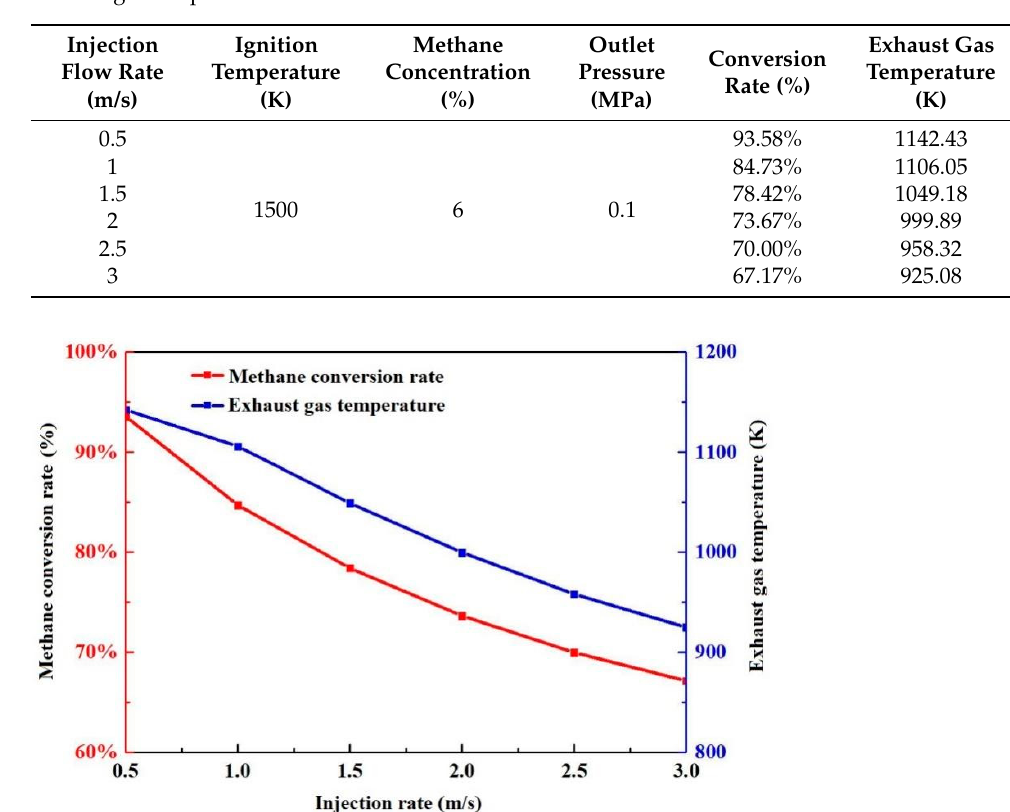
Figure 12. Conversion rate and exhaust temperature at different injection rates.